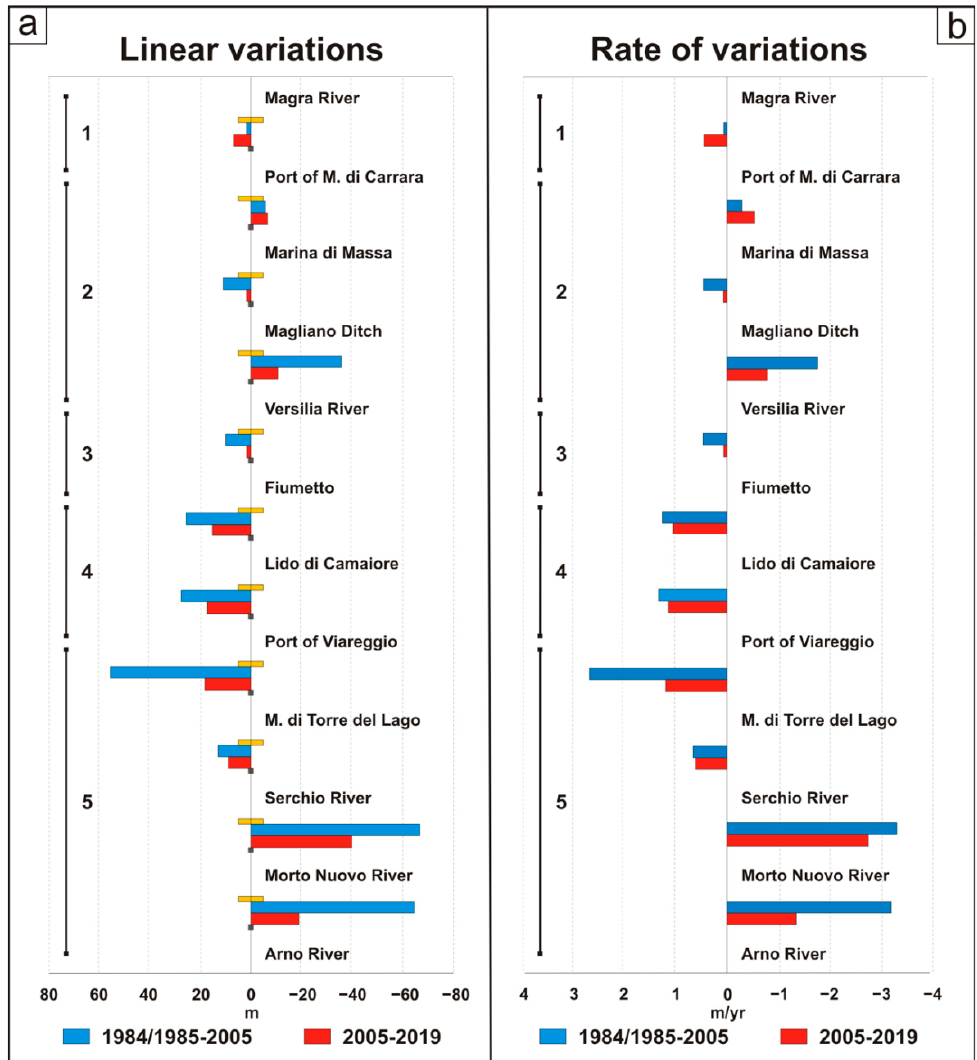
Figure 6. The diagrams show ( a ) the shoreline linear variations and ( b ) the rate of shoreline variations in the 1984/1985–2005 (according to [85]) and 2005–2019 timespans along the study area. The numbers to the left of each panel correspond to the sub-cells we considered for the anthropogenic sediment budget calculation. The yellow and the gray bars beside the blue and red bars, respectively, represent the uncertainty related to the calculation of shoreline variations in the two time intervals considered.